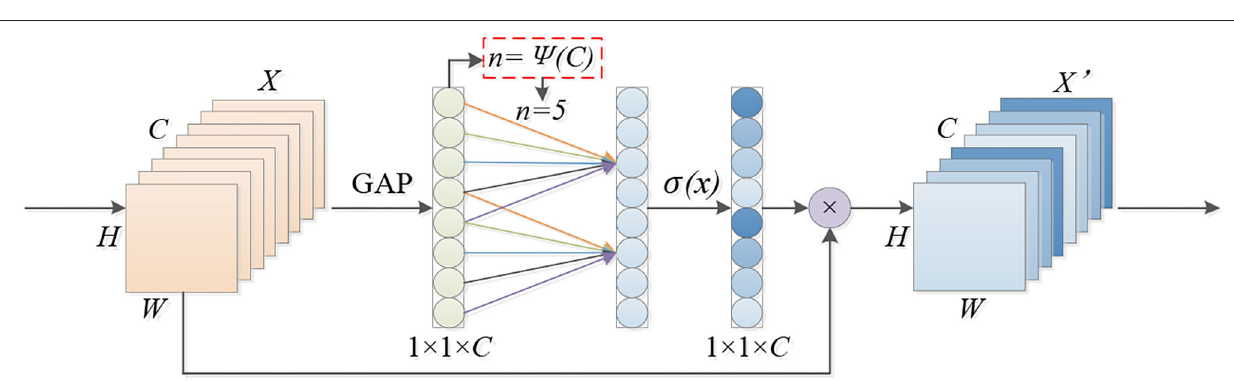
FIGURE 5 | Efficient channel attention